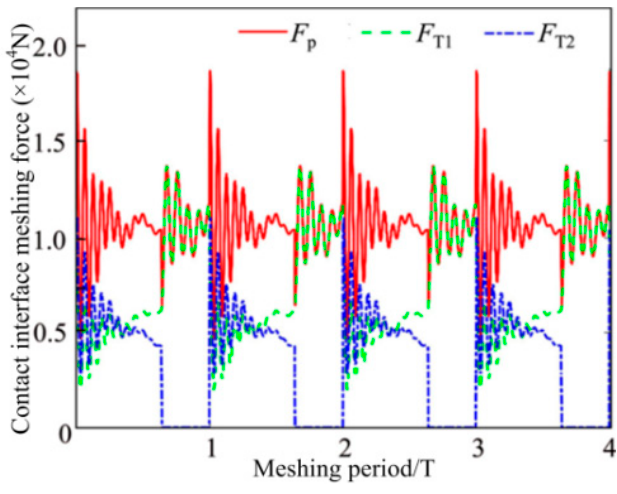
Figure 8. Dynamic gear tooth DMF of each MGP.